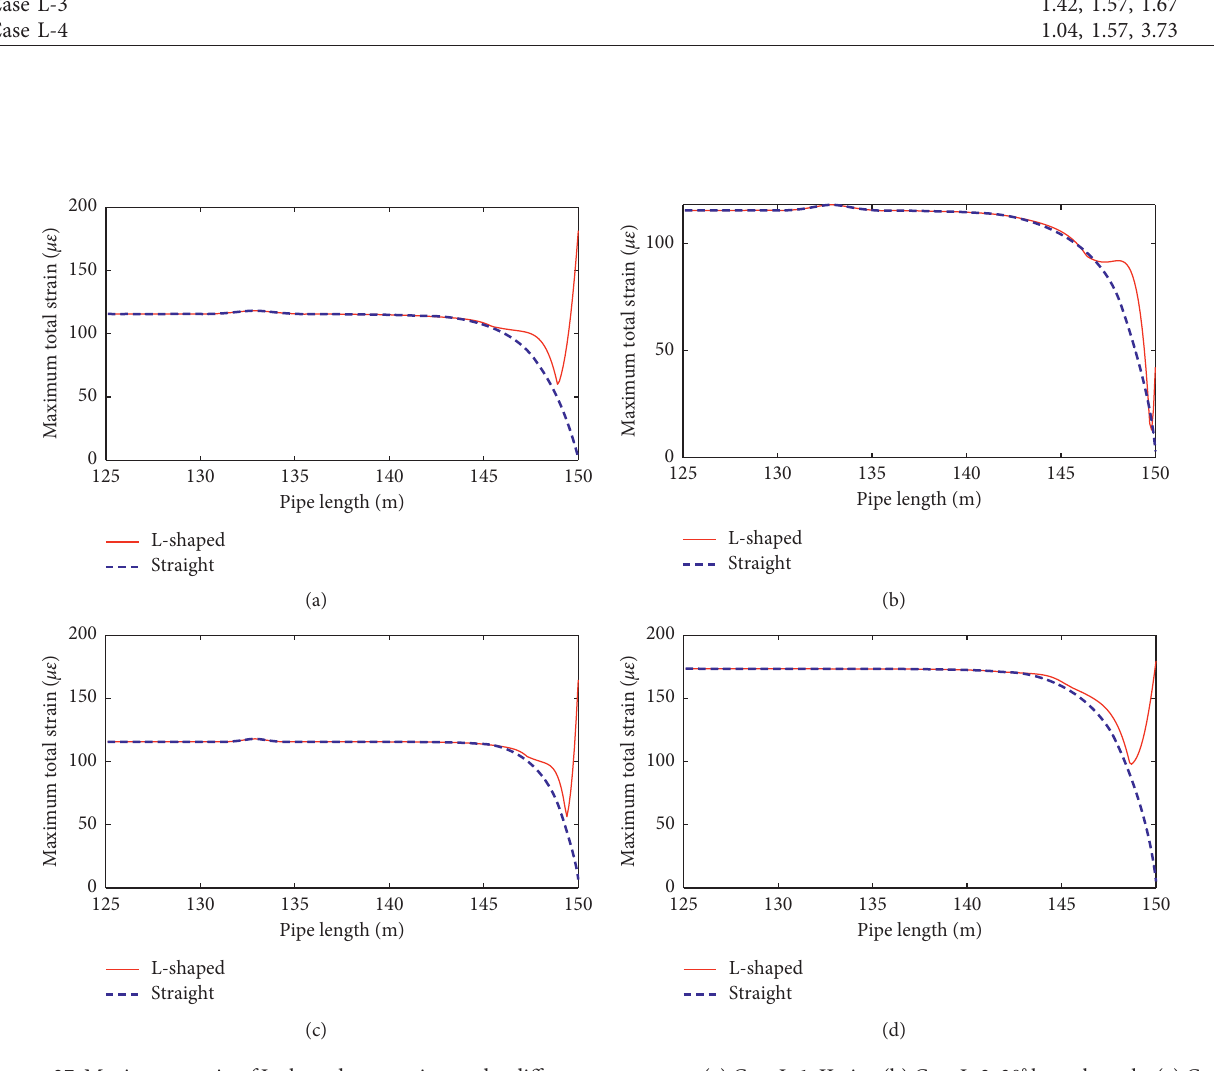
Figure 27: Maximum strain of L-shaped connection under different parameters: (a) Case L-1, II-site; (b) Case L-2, 30 ° branch angle; (c) Case L-3, 0.2191m pipe diameter; (d) Case L-4, 30 ° incident